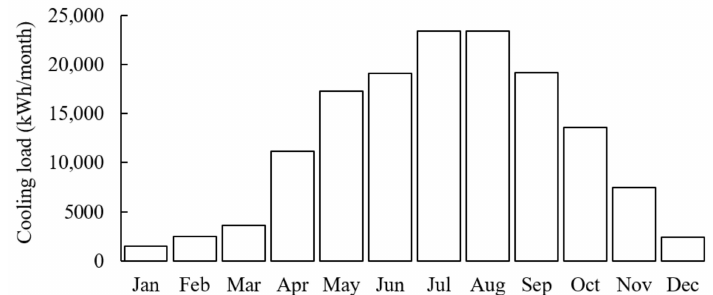
Figure 2. Monthly cooling load distribution of small-scale building air conditioning